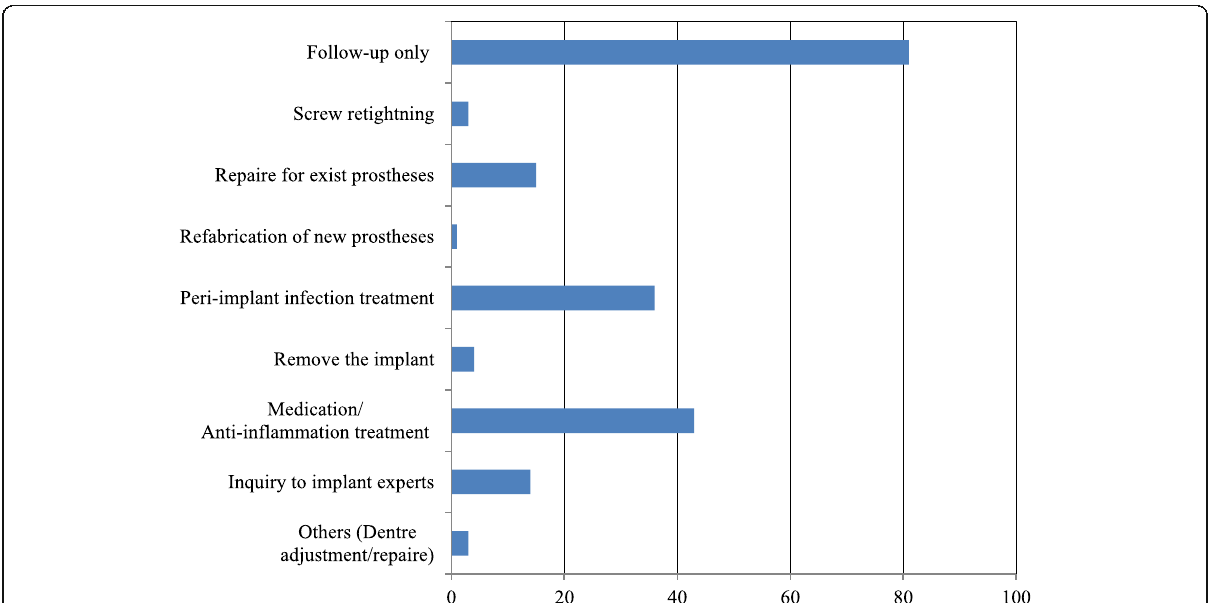
Fig. 3 Q7. Countermeasures/treatment for implant-related problems and complications (multiple answers were